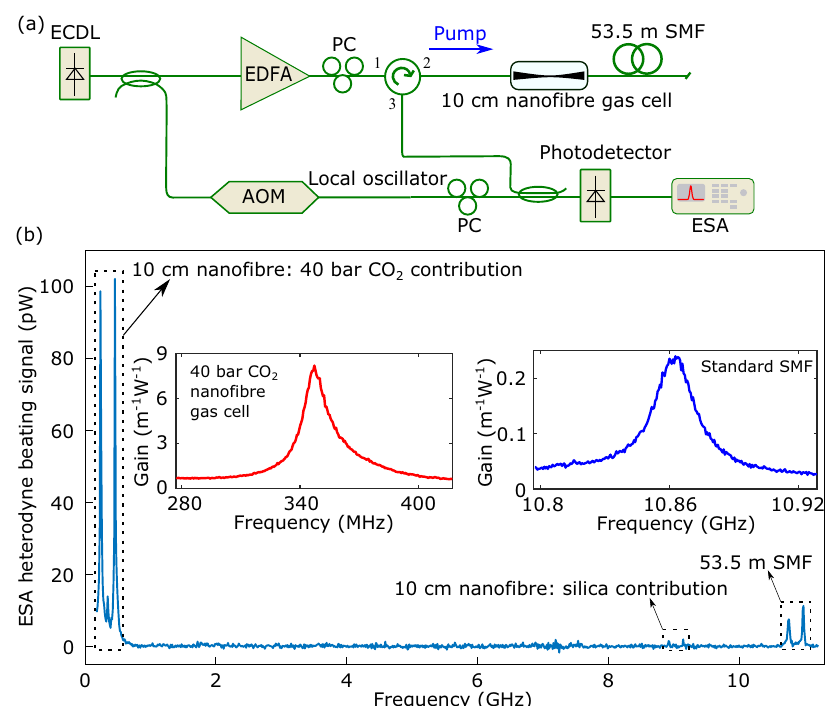
Fig. 4 Backward Brillouin scattering in the nano fi bre gas cell. a Heterodyne experimental set-up. To make a comparison between peak Brillouin gains, a 53.5 m single-mode fi bre (SMF) is connected to the far end of the nano fi bre. The output of a continuous-wave external-cavity diode laser (ECDL) is split: one branch is ampli fi ed by an erbium-doped fi bre ampli fi er (EDFA) and used to pump the nano fi bre as well as the SMF. The other branch is up-shifted in frequency ( + 110 MHz) by an acousto-optic modulator (AOM) and combined with the backward spontaneous Brillouin scattering for heterodyne mixing. The total length of the nano fi bre (including the adiabatic tapering transition and the nano fi bre waist) is 179.4 mm ± 5 mm with a 10 cm long 740 nm ± 5 nm diameter nano fi bre. Note that the total insertion loss of the nano fi bre is 1 dB including the 0.14 dB tapering-induced loss, the splicing loss of the nano fi bre to two fi bre pigtails at each end, as well as the loss of the two angled-physical contact connectors. The heterodyne spectrum is measured by a photodetector combined with a radio-frequency electrical spectrum analyser (ESA). The AOM is used to separate the Stokes and anti-Stokes Brillouin scatterings. The polarisations of the pump light and the local oscillator are adjusted using two polarisation controllers (PCs) to achieve the highest heterodyne response. b Heterodyne beating spectra of the 10 cm nano fi bre gas cell and the appended 53.5 m SMF. The Brillouin frequency shifts of the 40 bar CO 2 in the 10 cm nano fi bre gas cell, the silica contribution in the 10 cm nano fi bre gas cell as well as the 53.5 m SMF are 0.34 GHz, 9 GHz and 10.86 GHz, respectively. The red and blue lines in the inset of (b) are the backward Stokes Brillouin gain spectra for the 40 bar CO 2 nano fi bre gas cell and for the SMF, respectively. The horizontal scales span over the same frequency width for a good comparison.